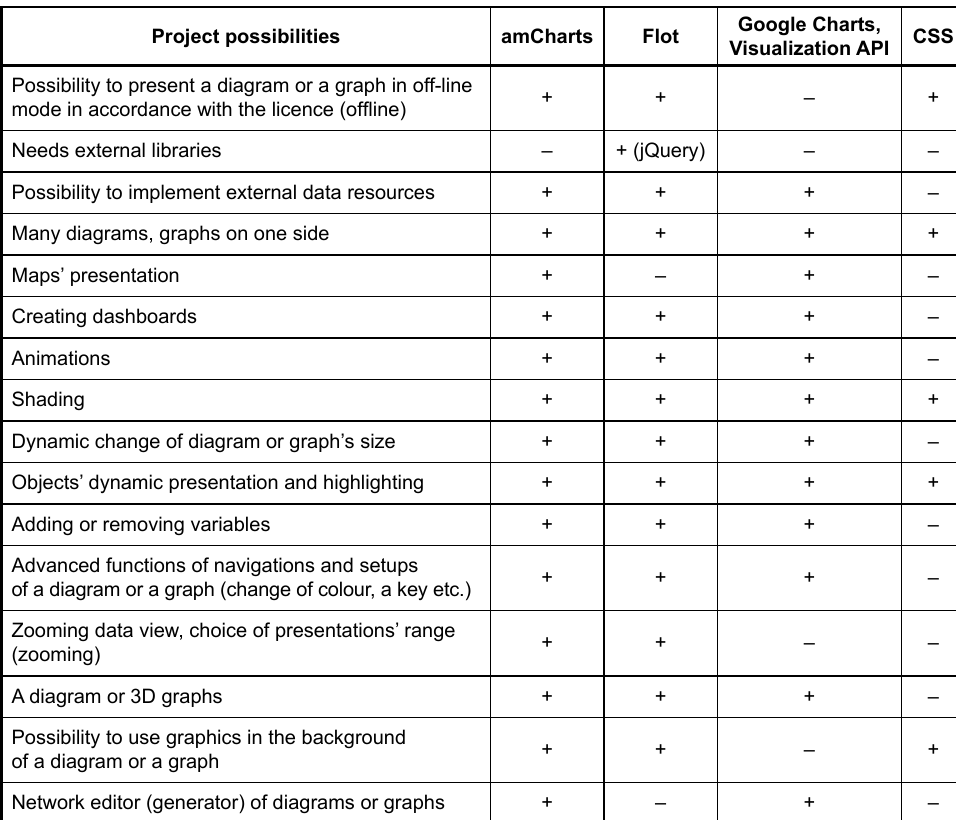
Table 9. Comparative analysis of the selected design